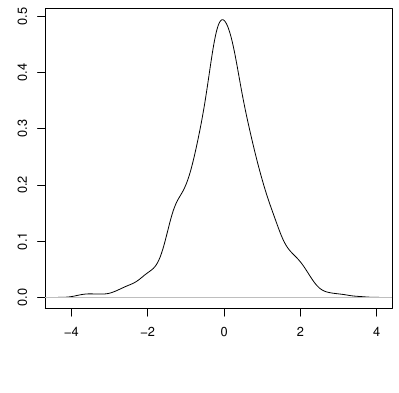
Figure 1 – A leptokurtic distribution with kurtosis 5.14.